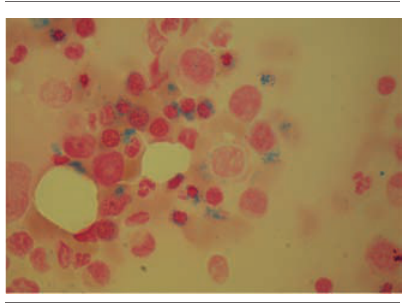
Figure 2. Hypercellular bone marrow aspi- rate with dysplastic erythropoiesis.